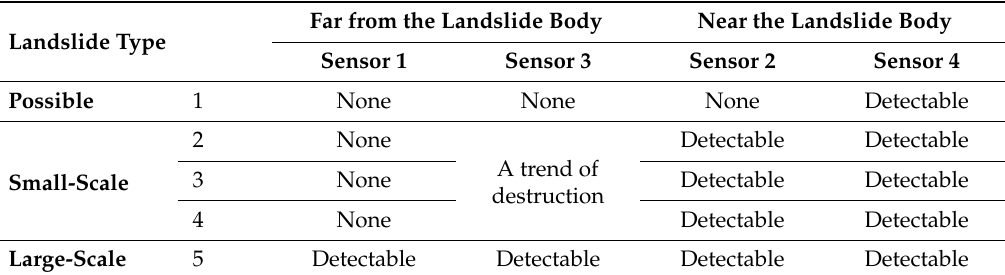
Table 2. Monitoring results of different